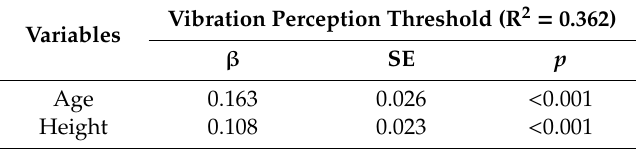
Table 4. Linear regression model explaining root vibration threshold ( n =